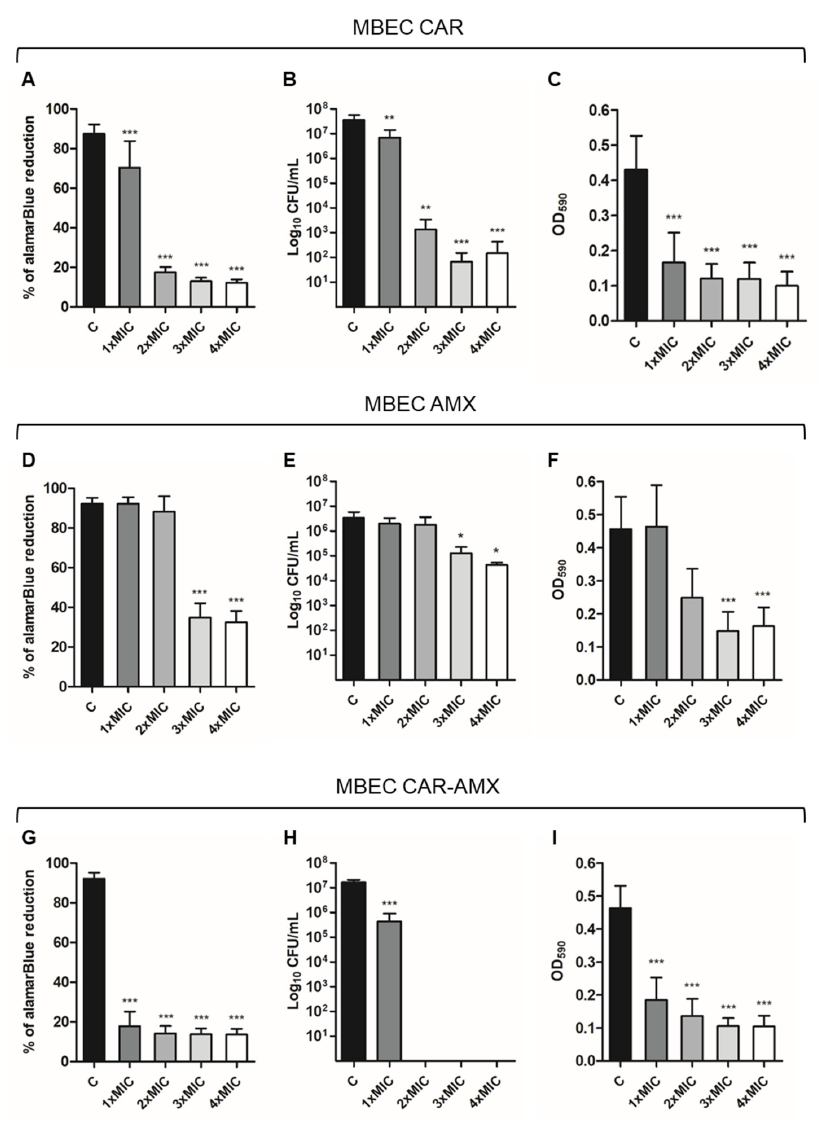
Figure 2. In vitro activity of CAR and AMX alone and in combination against H. pylori preformed